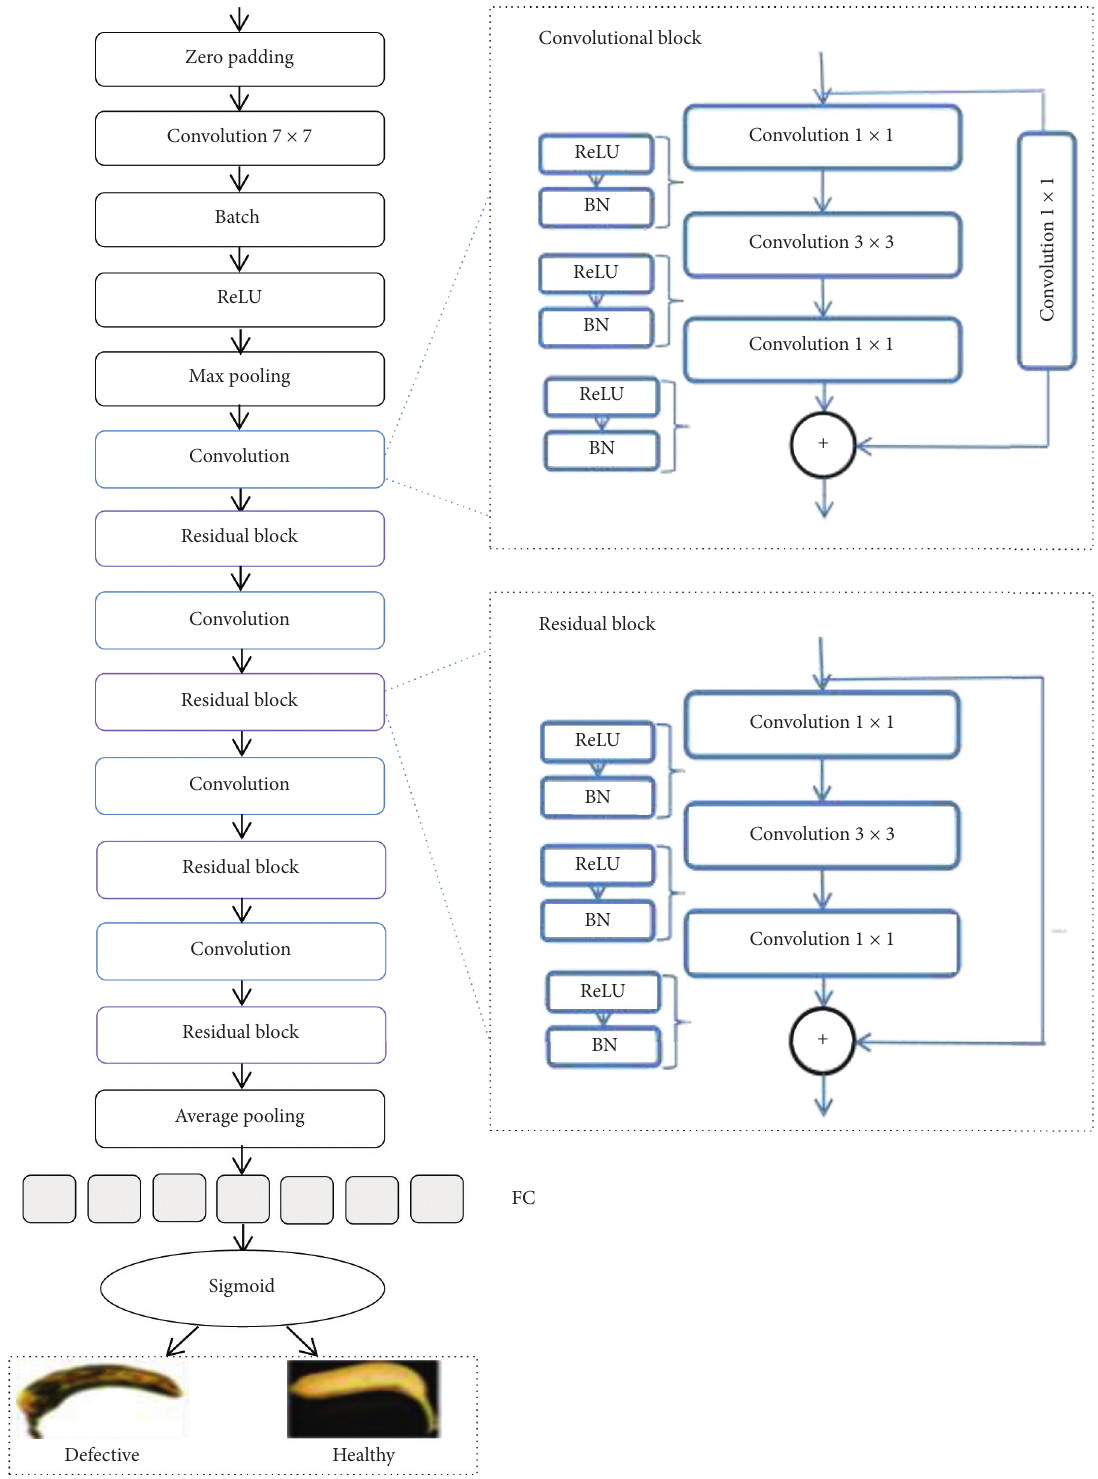
Figure 4: ResNet transfer learning process for the bananas sorting system. BN, batch normalization; FC, fully connected